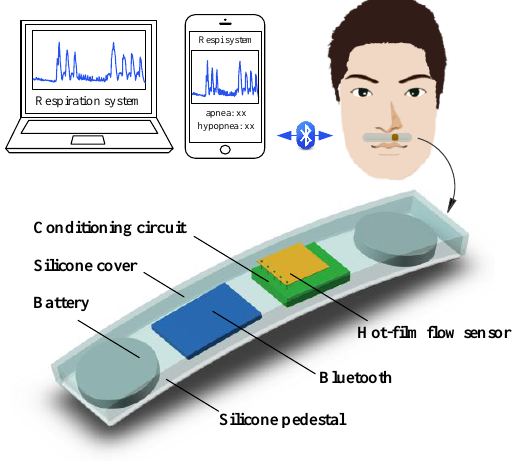
Figure 1. Schematic of the system.